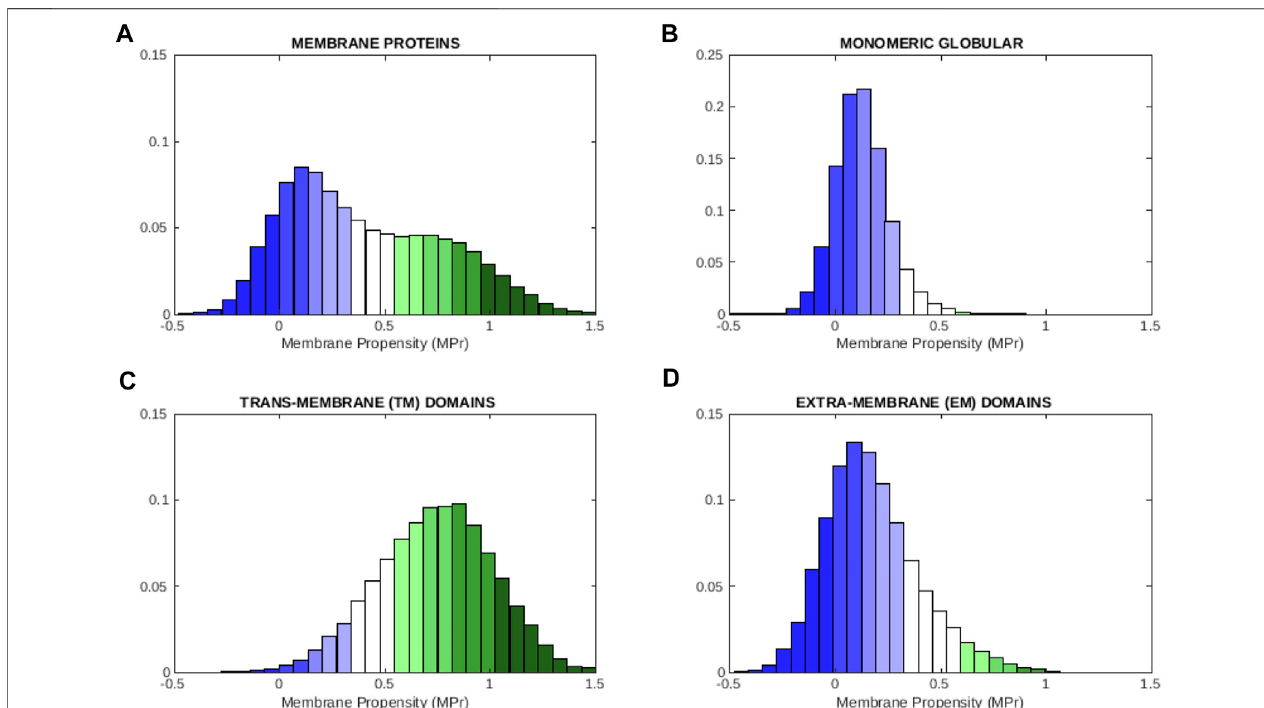
FIGURE1| DistributionofMPrscorescomputedfromdifferentofproteindatasets: (A) membraneproteins D mem , (B) globularproteins D glob , (C) TMregions D TM mem and (D) EM regions D EM mem . The color code is de fi ned in Table 2 .